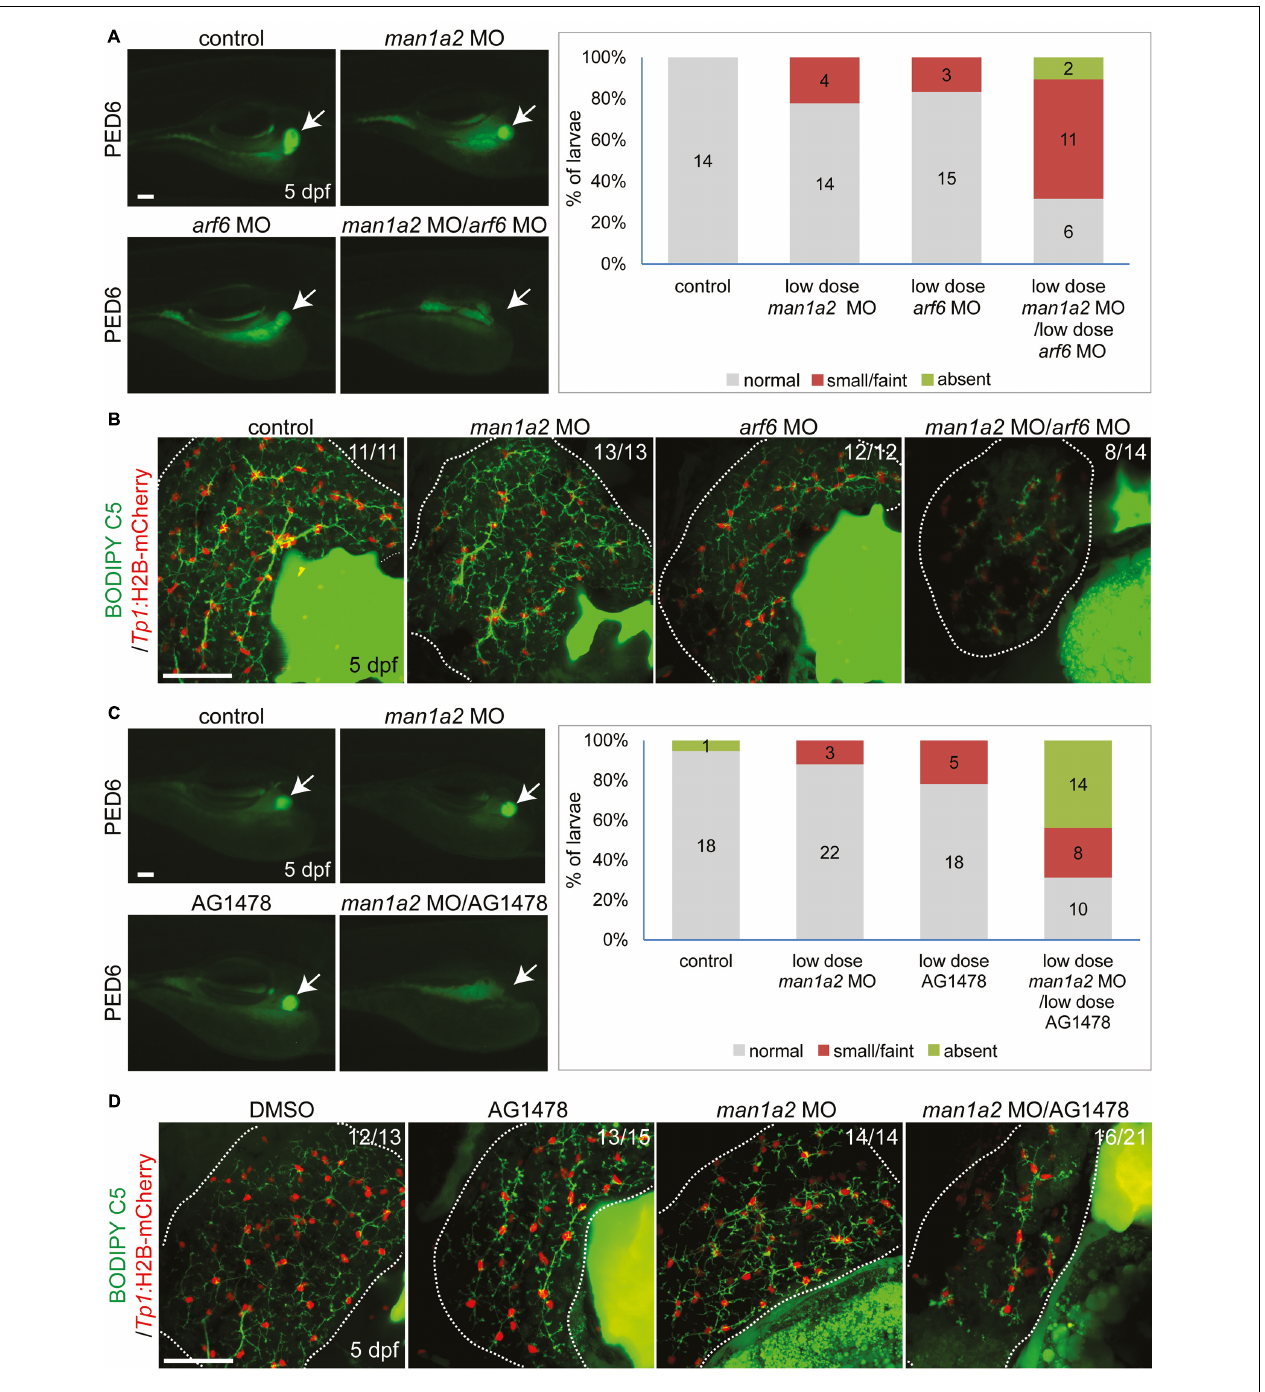
FIGURE 4 | Genetic interaction among man1a2 , arf6 and EGFR signaling in intrahepatic biliary network formation . (A,C) Epifluorescence images of larvae treated with PED6 and its quantification. Suboptimal doses of man1a2 (1.5 ng) and arf6 (0.5 ng) MOs were singly or in combination injected into embryos at the one-cell stage (A) . Embryos were first injected with the suboptimal dose of man1a2 MO (1.5 ng) and from 60 hpf treated with a suboptimal dose of AG1478 (1 µ M) (C) . Arrows point to the gallbladder. Graphs show the percentage of larvae in each group. Numbers in the graph indicate the number of larvae in each group. (B,D) Confocal images of the liver showing the intrahepatic biliary network, as revealed by BODIPY-FL C5 feeding (green, biliary ductal network) and Tp1 :H2B-mCherry (red, BEC nuclei) expression. Single injection of suboptimal doses of either man1a2 or arf6 MO did not impair proper intrahepatic biliary network formation, whereas their co-injection resulted in defective biliary network formation (B) . The biliary network formation was not impaired in larvae only treated with AG1478, whereas it was impaired in AG1478-treated larvae with man1a2 partially knockdown (D) . Numbers in the upper right corner are the fraction of larvae exhibiting the representative phenotype shown. Dotted lines outline the liver. Scale bars: 50 µ